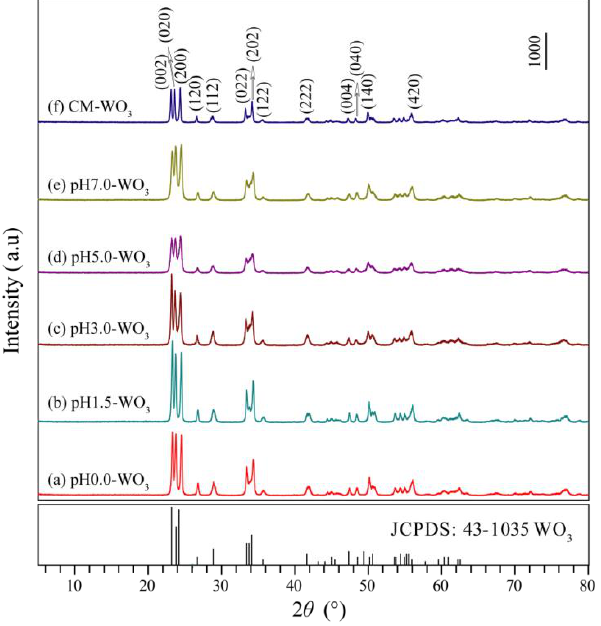
Figure 2. XRD patterns of WO 3 samples synthesized by hydrothermal method using tungstic acid colloidal suspension with different pH values (0.0 – 7.0): ( a ) pH0.0-WO 3 , ( b ) pH1.5-WO 3 , ( c ) pH3.0-WO 3 , ( d ) pH5.0-WO 3 , ( e ) pH7.0-WO 3 , and ( f ) the commercial WO 3 (CM-WO 3 ) sample.